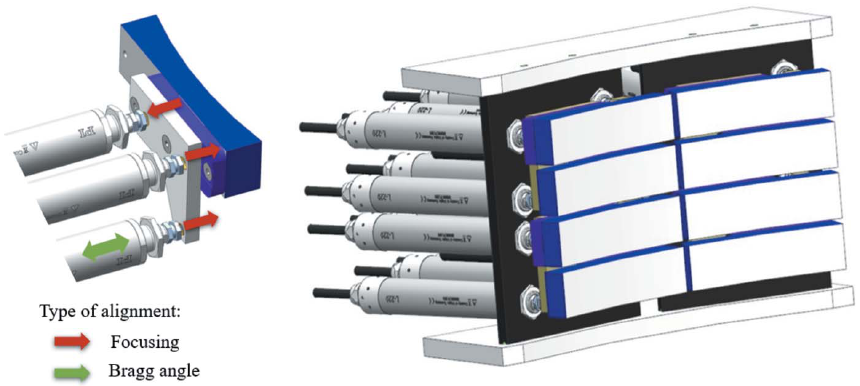
Figure 5 (Left panel): one crystal driven by three linear actuators. Right panel: a view of the XES